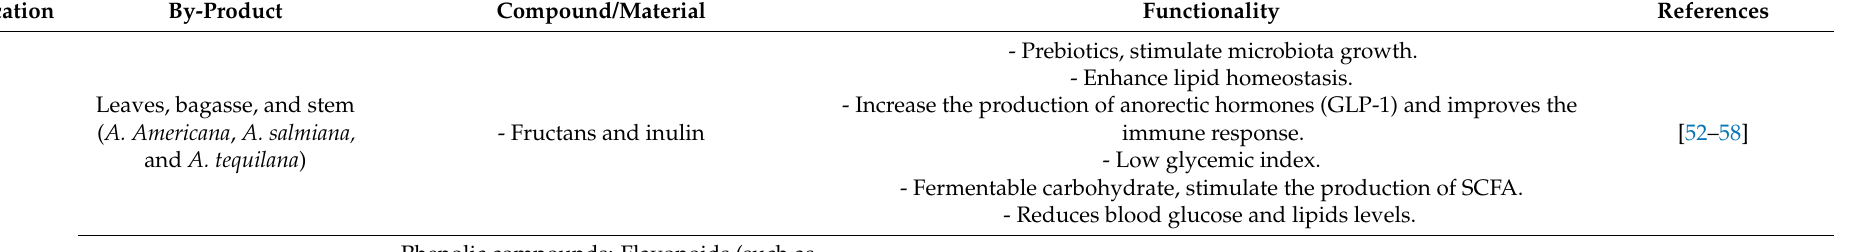
Table 2. Functional properties and main applications of agave